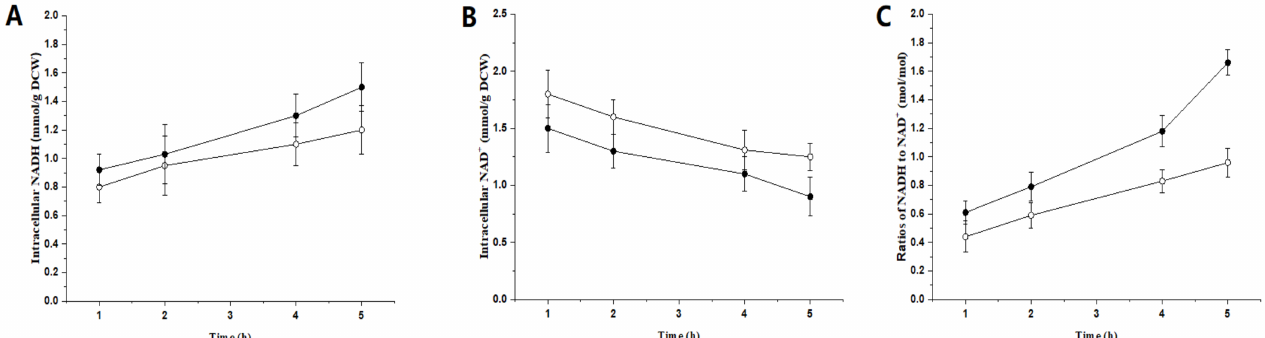
Figure 5. Effects of NADH regeneration system on levels of intracellular NADH, NAD+ and ratios of NADH to NAD+. Circular (Solid) represents Serratia marcescens MG1ABC (pSWNB+pETDuet-bdhA-fdh). Circular (Hollow) represents Serratia marcescens MG1ABC (pSWNB+pETDuet-bdhA). ( A ) Effects of NADH regeneration system on levels of intracellular NADH; ( B ) Effects of NADH regeneration system on levels of intracellular NAD+; ( C ) Effects of NADH regeneration system on ratios of NADH to